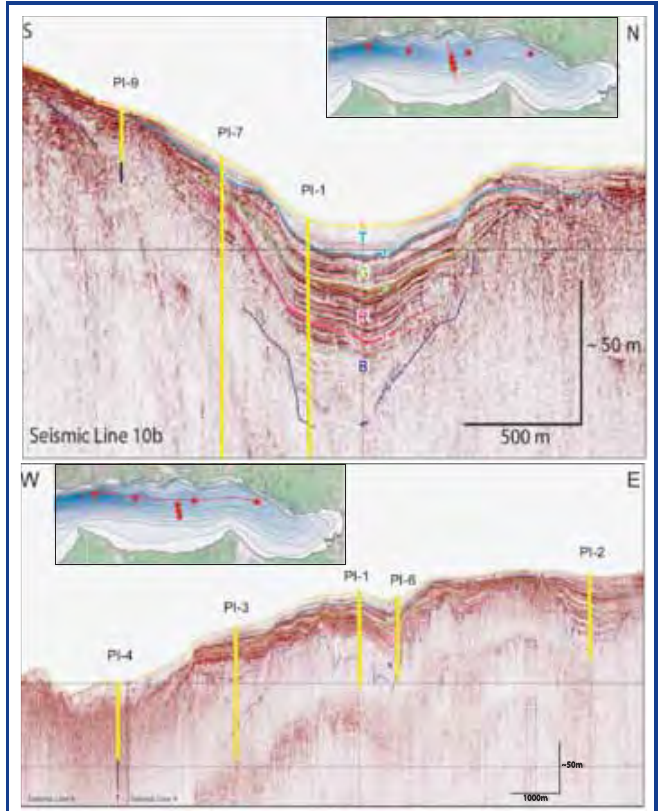
Figure 2. Top: Airgun seismic profi le line 10b oriented N-S with drilling penetration depths of Sites PI-9, PI-7, and PI-1. Bottom: Airgun seismic profi les 8 and 9 oriented E-W with drilling penetration depths of Sites PI-2, PI-6, PI-1, PI-3, and PI-4 (Site PI-1 projected). Inset lake maps shows posi- tion of seismic